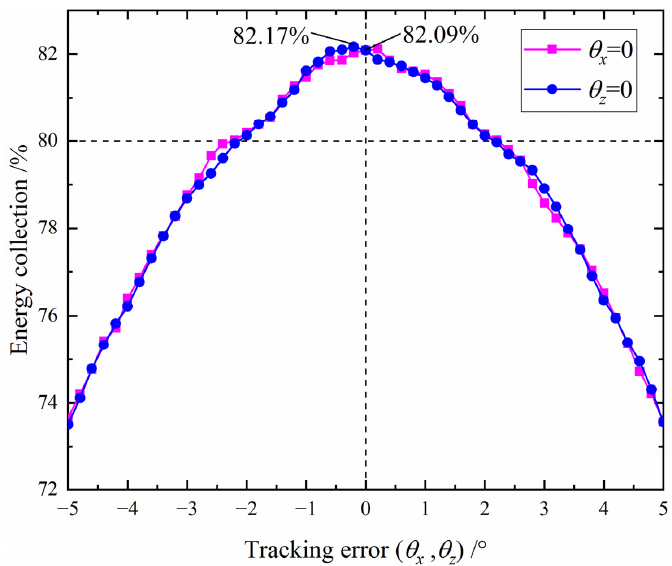
Figure 14. The total energy collection with different tracking errors.